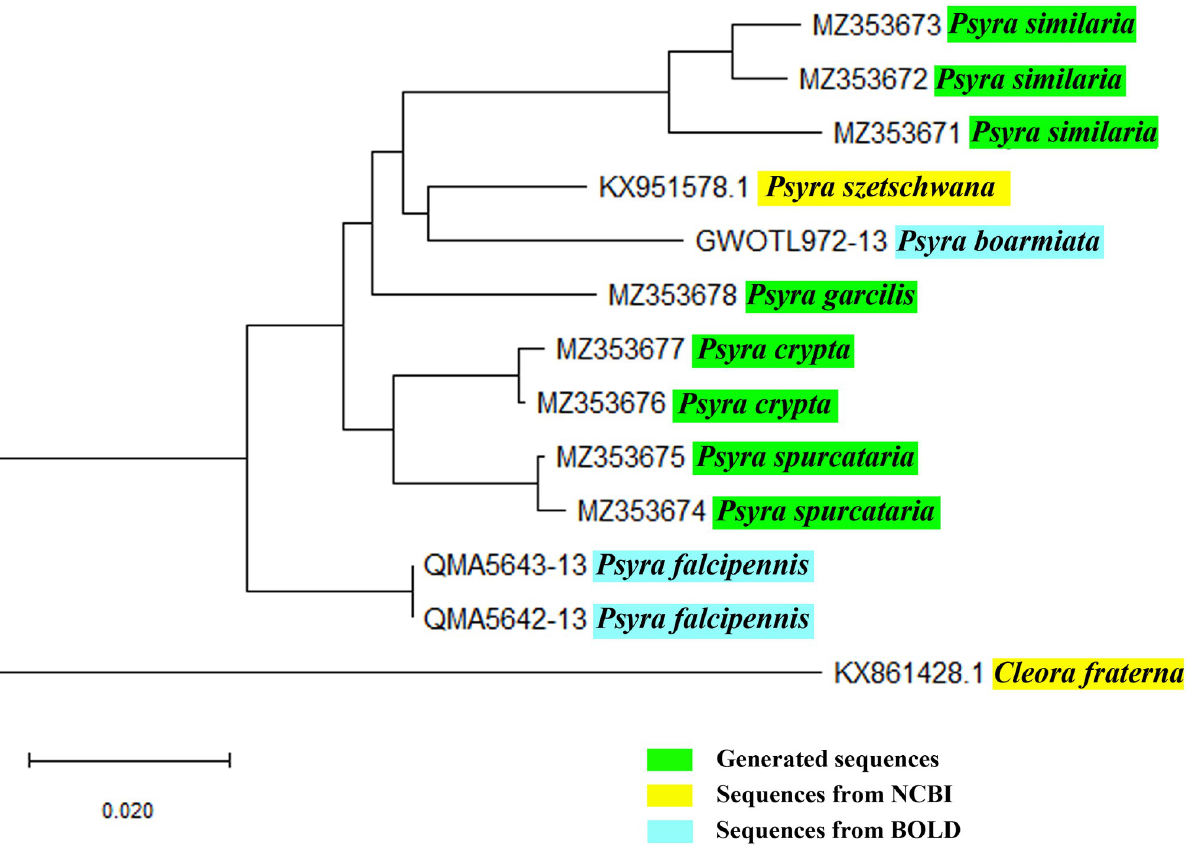
Fig 15. Neighbour-joining (NJ) phylogenetic tree of Psyra species constructed with 1,000 bootstraps of replications using Kimura-2-parameter (K2P) model. Eight DNA sequences of 4 morphologically identified species from our collection was aligned against four globally available sequences of three Psyra species along with Cleora fraterna as an outgroup, retrieved from the National Centre for Biotechnology Information (NCBI) and Barcode of Life Database (BOLD).